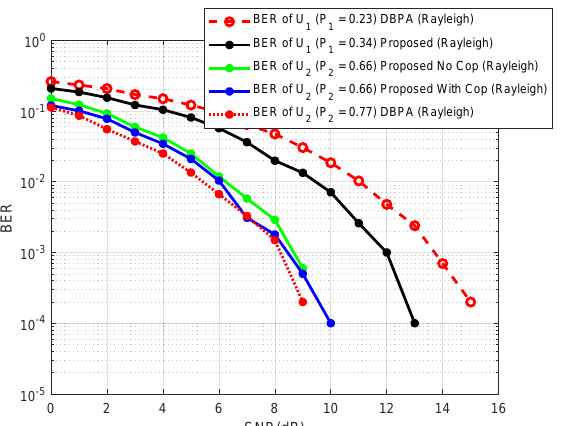
Figure 12. BER performance for two users, in the proposed FIS based model in Rician (SUI-3) Channel Model.